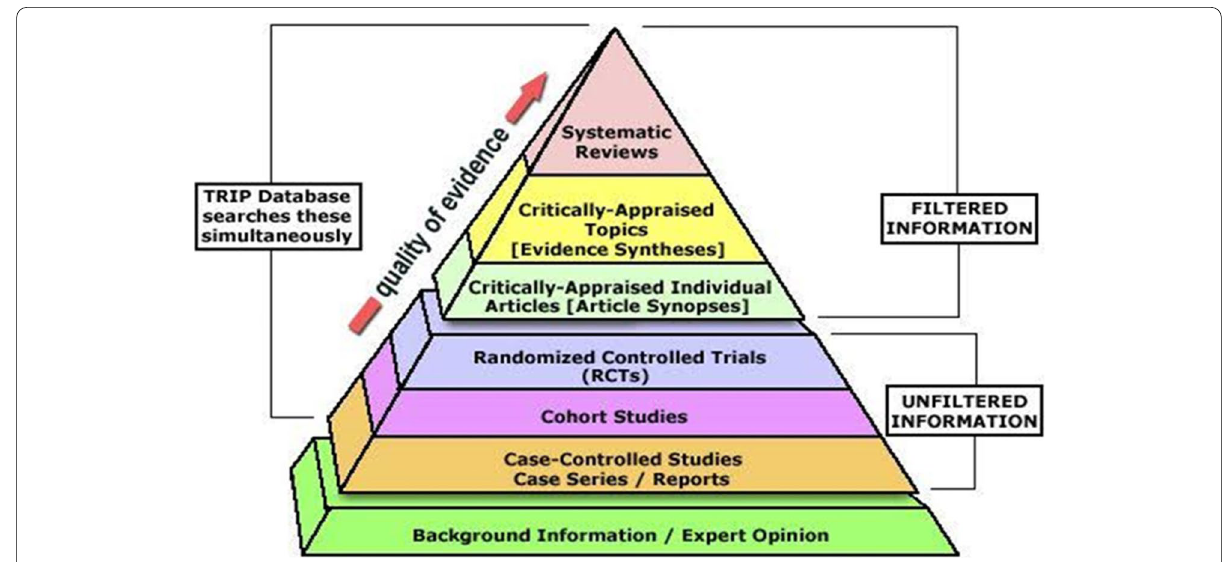
Fig. 1 Levels of evidences (hierarchy of evidence level). https:// images. app. goo. gl/ Zd2XL 933/i/ wFJNA9